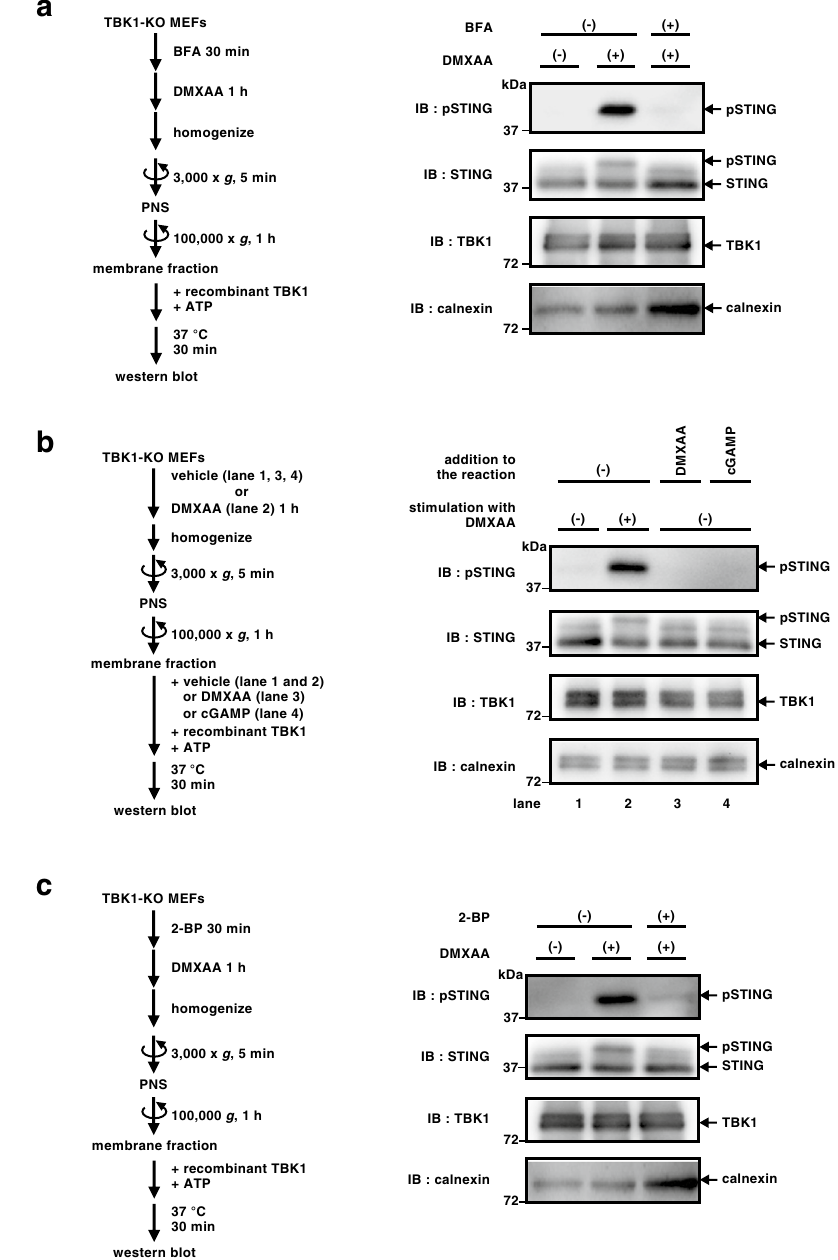
Figure 3. Phosphorylation of STING by TBK1 in vitro requires “ER-to-Golgi” traffic and palmitoylation of STING. ( a ) TBK1-knockout MEFs were treated with brefeldin A (3 µg/mL) for 30 min followed by the stimulation with DMXAA for 1 h. The post-nuclear supernatants of cells were centrifuged at 100,000 × g . The resulting membrane fraction was resuspended, incubated with recombinant TBK1 in the presence of ATP, and analyzed by western blot. ( b ) Post-nuclear supernatants of unstimulated TBK1-knockout MEFs were centrifuged at 100,000 × g . The resulting membrane fraction was resuspended and incubated with recombinant TBK1 and ATP in the presence of DMXAA (25 µg/mL) or 2 ′ 3 ′ -cGAMP (250 ng/mL) at 37 °C for 30 min. Phosphorylation of STING at Ser365 was analyzed by western blot. ( c ) TBK1-knockout MEFs were treated with 2-bromopalmitate (50 µM) for 30 min followed by the stimulation with DMXAA for 1 h. The membrane fraction of the cells was resuspended, incubated with recombinant TBK1 in the presence of ATP, and analyzed by western